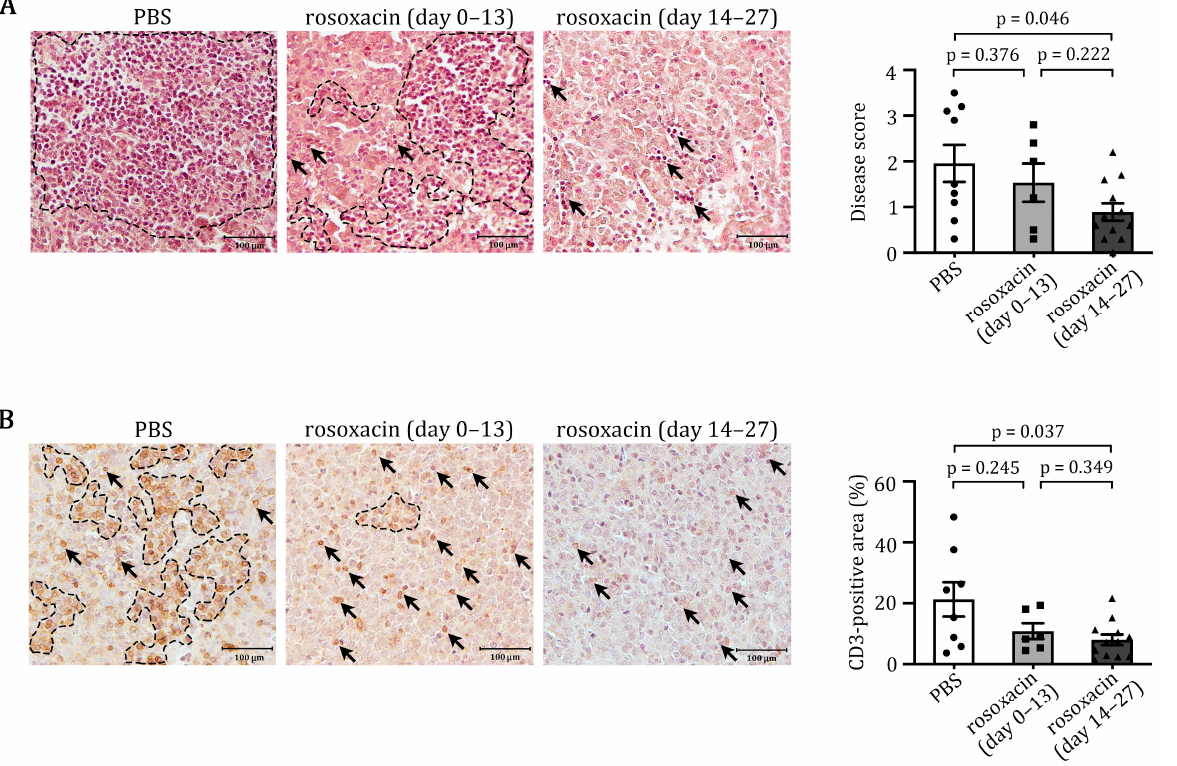
Figure 2. Rosoxacin suppressed EAH development. ( A ) Mice that developed EAH were treated with PBS or rosoxacin at early (day 0–13) or late (day 14–27) stages. Treated mice were sacrificed and the pituitaries were cut and stained with H&E. Infiltrating mononuclear cells in the sections were enclosed by dashed line or indicated by arrows. Scale bar: 100 µ m. ( B ) Pituitary sections of the mice were immunostained for CD3 T cells. CD3 + T cells in the sections are enclosed by dash-line or indicated by arrows. Each symbol (circles, squares, and triangles) in the histogram plots represents the averaged data of a single mouse. Scale bar: 100 µ